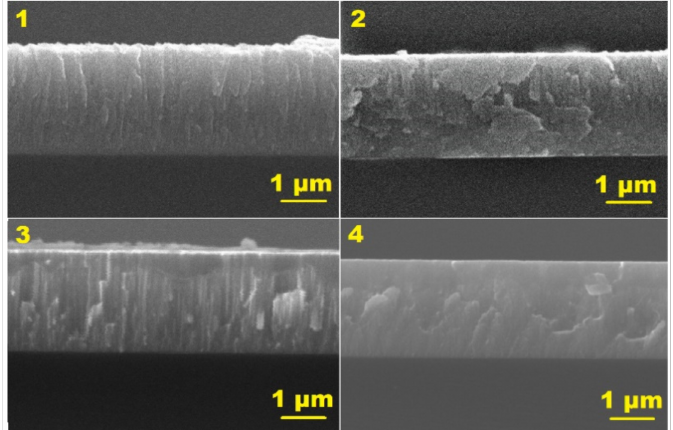
Figure 4. SEM images of cross-sectional microstructure of Cr coatings obtained on Si (110) substrates depending on their deposition modes: 1—dep. mode #1; 2—dep. mode #2; 3—dep. mode #3; 4—dep. mode